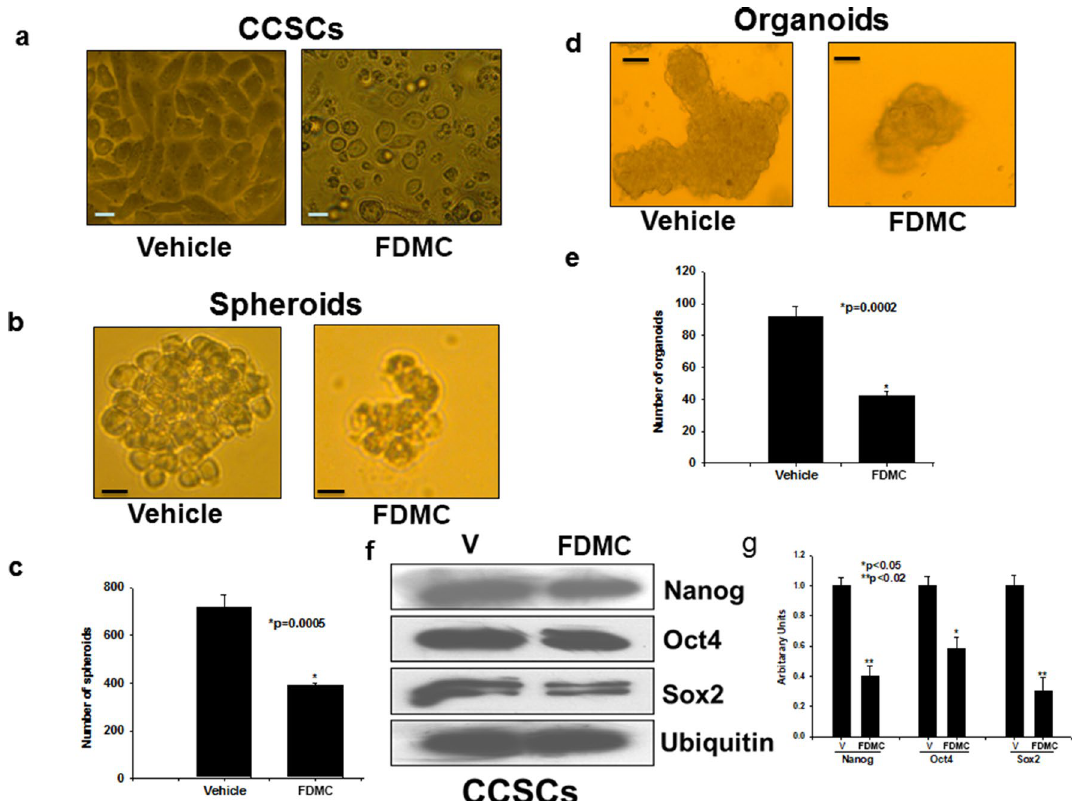
Figure 4. Effect of FDMC on morphology, self-renewal capacity, organoid formation, and expression of pluripotency transcription factors in CCSCs, as evidenced by comparisons with vehicle-treated controls (V = vehicle). ( a ) Microscopic image shows that CCSCs became spherical after 24 h of FDMC (50 µM) treatment, in contrast to vehicle-treated cells. ( b ) Microscopic image shows that FDMC (50 µM) inhibited self- renewal (spheroid formation) of human CCSCs (CD24 + CD44 + LGR5 + ) grown in ultralow non-adherent plate containing stem cell-specific medium in 3D culture. ( c ) FDMC (50 µM) significantly inhibited the number of spheroids compared to vehicle (* p < 0.0005). ( d ) Microscopic image shows that FDMC (50 µM) inhibited CCSC- derived organoids formation when grown in Matrigel and stem cell-specific organoid medium in 3D culture. ( e ) FDMC (50 µM) significantly inhibited the number of organoids compared to vehicle (* p < 0.0002). ( f , g ) Western blot data show that FDMC (50 µM) significantly inhibited CCSC expression of the stem cell pluripotency transcription factors Nanog, Oct4, and Sox2 compared to vehicle (* p < 0.05 and ** p < 0.02). Data are from 3 independent